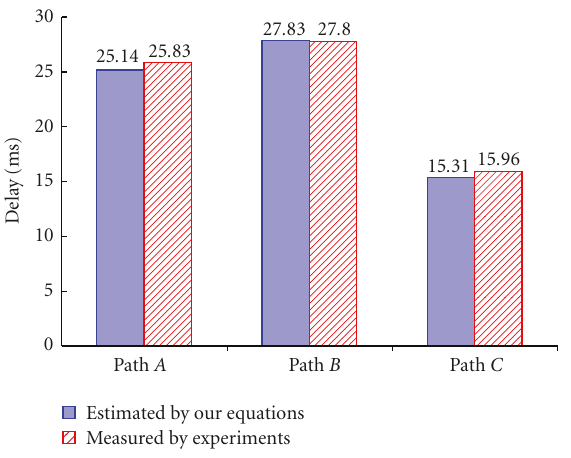
Figure 4: End-to-end delay.